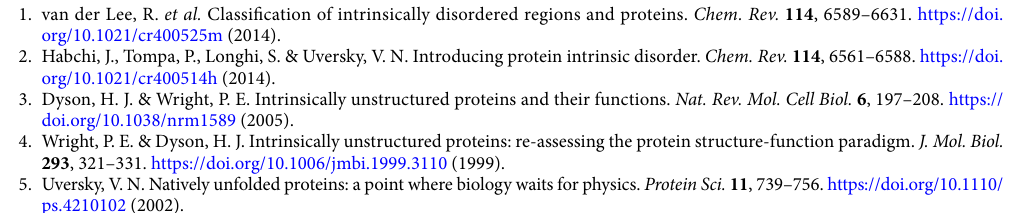
(Figure S2). According to the DSDR variation values calculated using the domain pairs (the difference value of the normalized DSDRs) (Figure S16B), we divided DSDR variation values into three levels: 0 (no-variation domain), 0–1 (low-variation domain) and 1–3 (high-variation domain). DSDR variation dominant categories were defined in a similar way (Figure